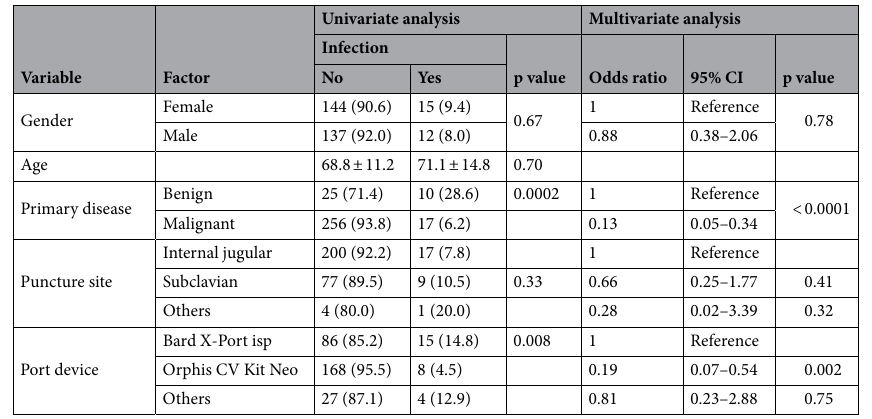
Table 3. Univariate and multivariate analyses to identify variables that are associated with CVP infection. CI confidence interval.